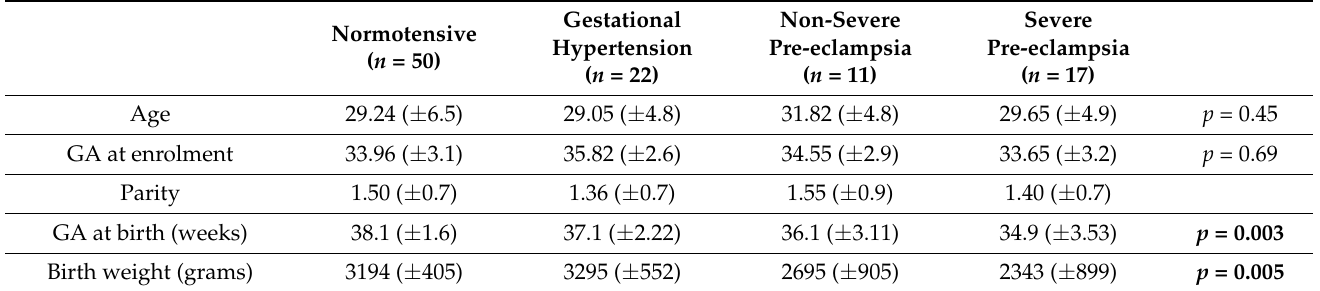
Table 1. Characteristics of the study